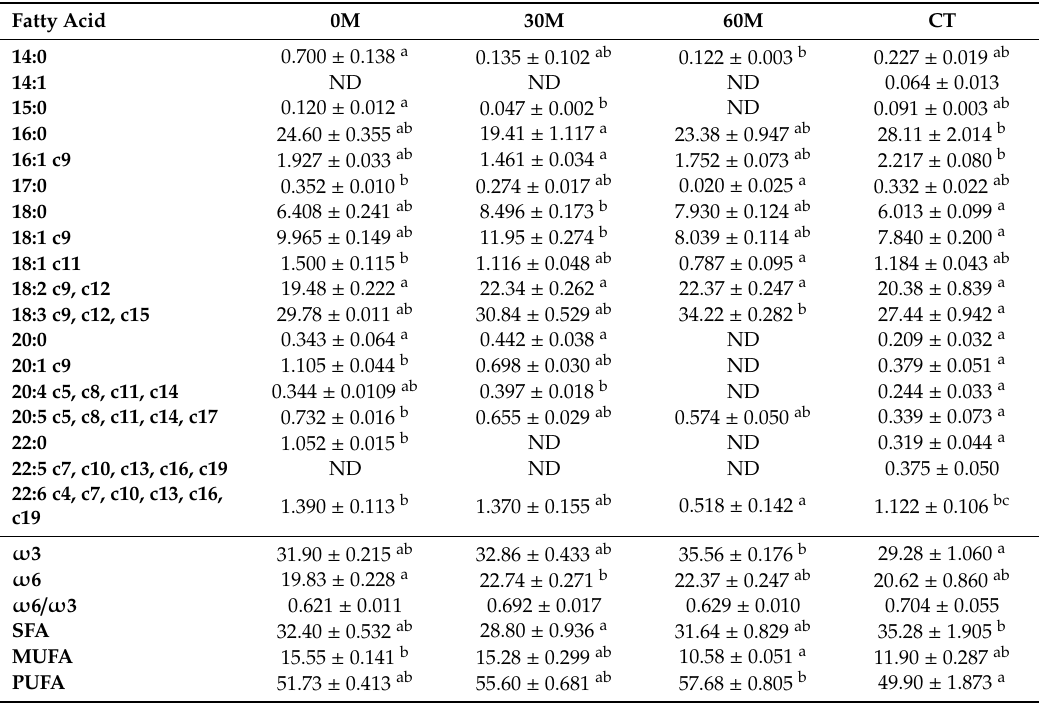
Table 2. The fatty acid profile of the PL extracts from tea leaf samples, before (0 min) and after 30 and 60 min of oxidation, in comparison to that of CT, expressed as a percentage of the total fatty acids of each sample (mean ± SD, n =